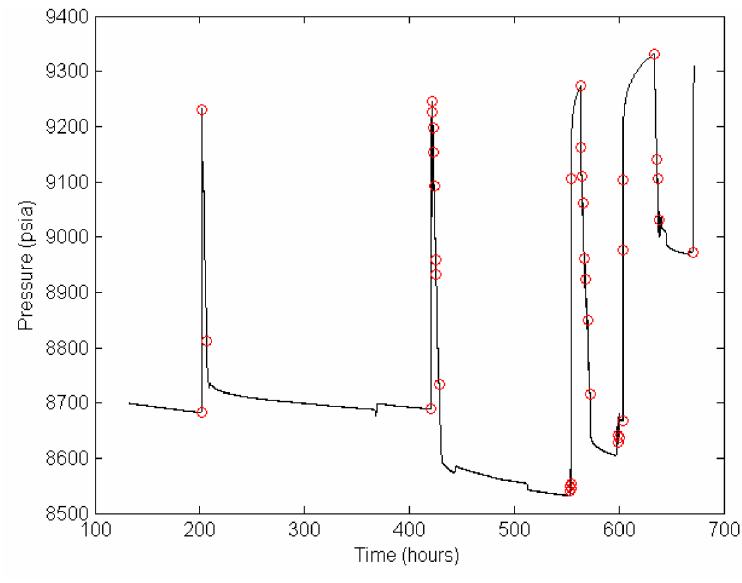
Figure 7. Detection result using the pressure derivative from Rai